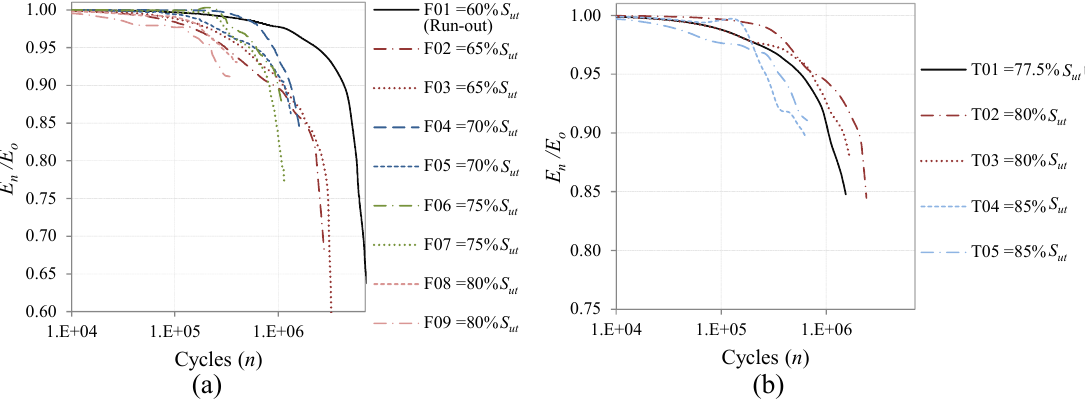
Figure 8. One area of inspection of the coupon C01 cycled at S max = 0.47 S ut ; ( a ) Topographic profile; ( b ) Power spectral density of the profile in log ‐ log scale. Figures 8b and 9b show the evolution of the surface spectral density function. The PSD results are presented in log ‐ log scale. The low frequencies increase due to the aforementioned increment of